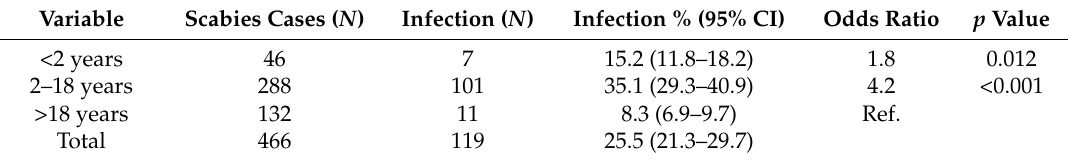
Table 4. Scabies secondary bacterial infection rate by age, Amhara region, Ethiopia